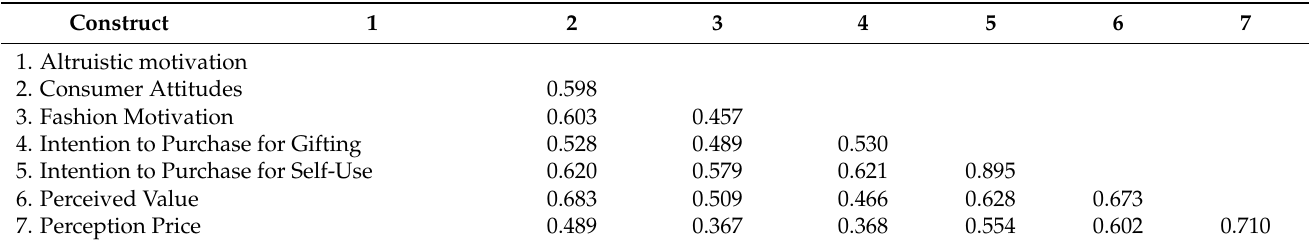
Table 2. Results of Discriminant